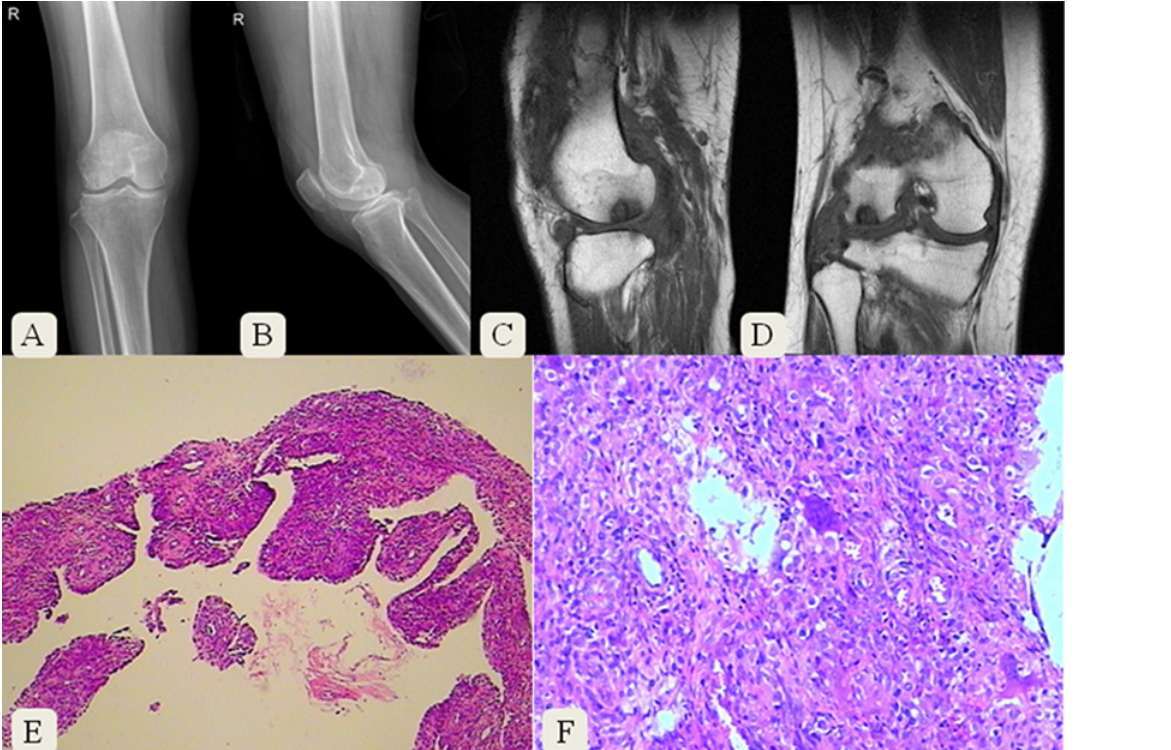
Fig 5. Radiographs, MRI and histopathological images of a 56-year-old female diagnosed with right knee PVNS.